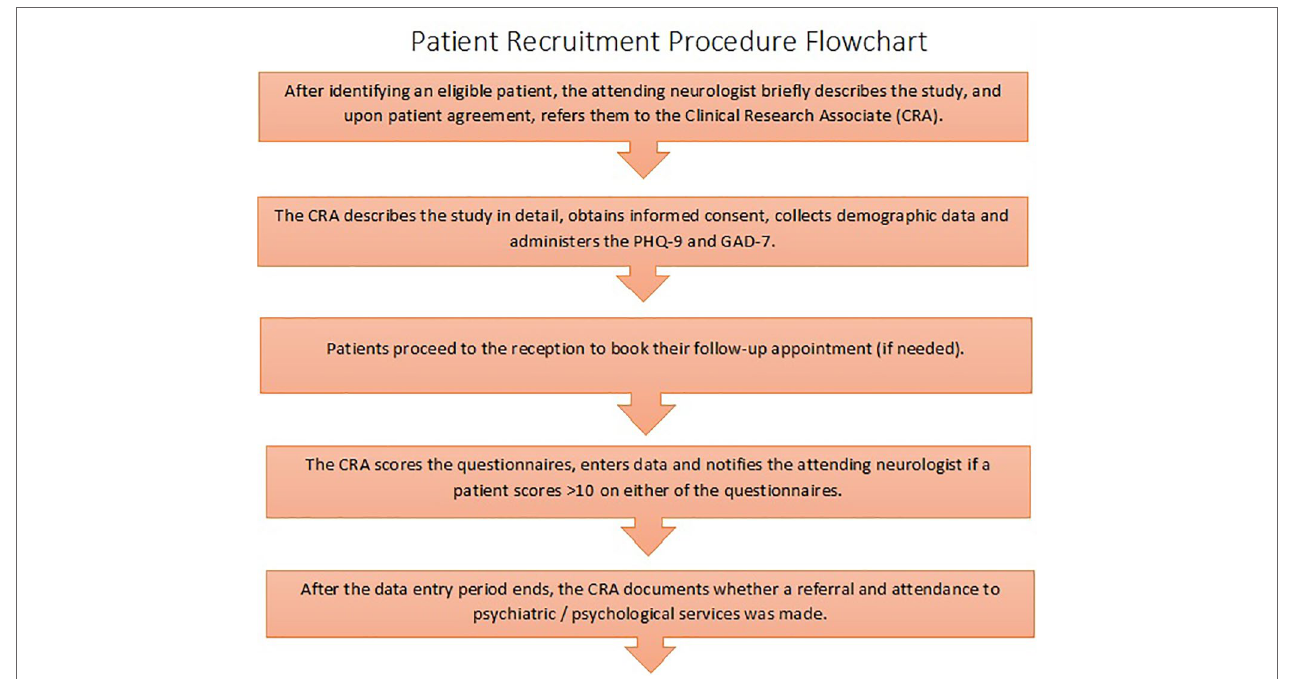
FIGURE 1 | Patient recruitment